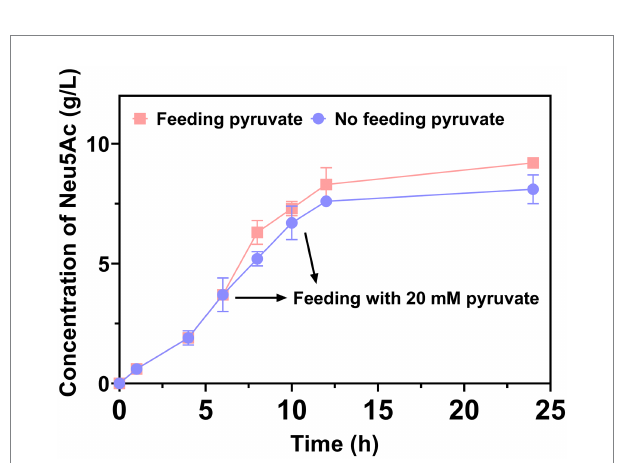
FIGURE 5 The production of Neu5Ac enhancement by feeding